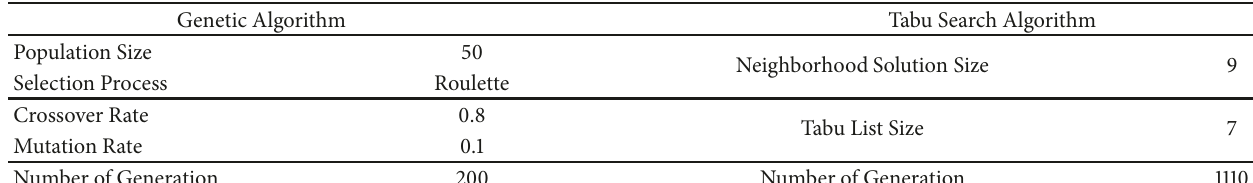
Table 6: The parameters of metaheuristics.